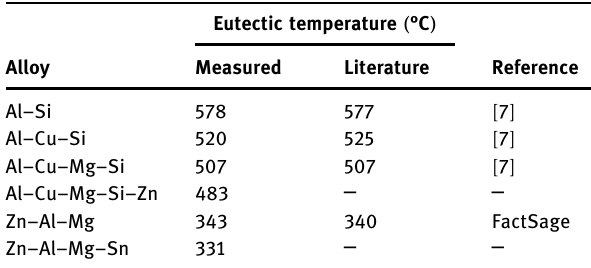
Table 4: Eutectic temperature, measured in this research and lit - erature values